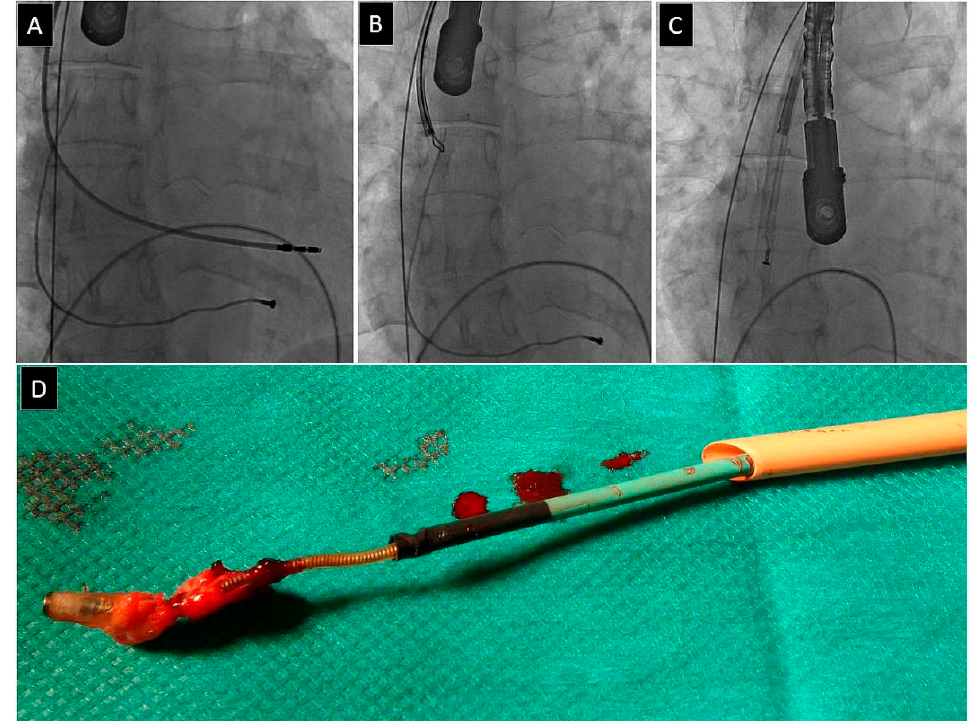
Figure 2. Lead fracture. The broken lead ( A ) can be removed via an inferior or superior approach (using a re-established vein access) ( B – D ). The latter technique enables the use of conventional tools for lead dilatation [3].